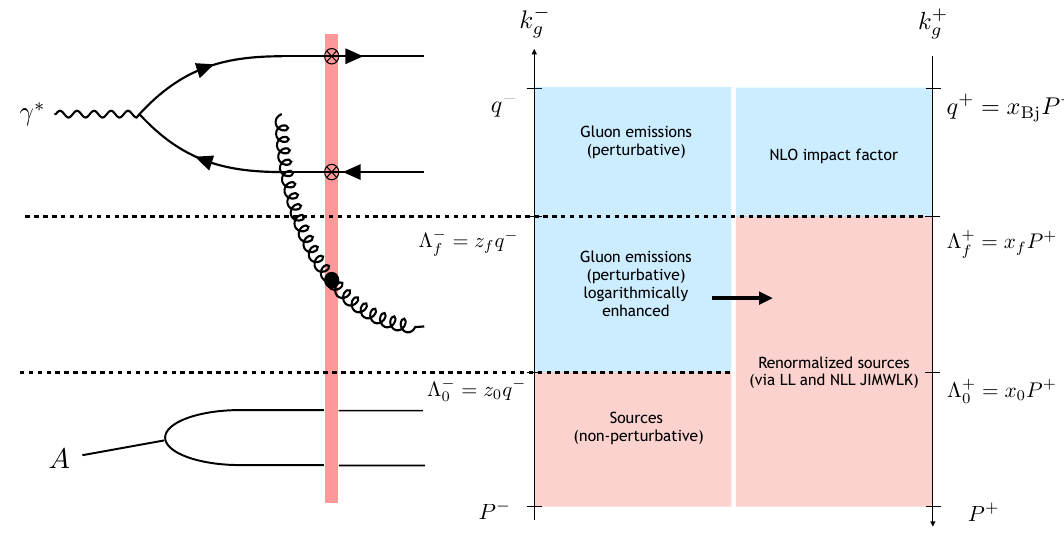
Figure 11 . Gluon emission (real or virtual) phase space. Fluctuations carrying “minus” (“plus”) lightcone momentum P − < k − < z 0 q − ( P + > k + > x 0 P + ) are accounted for in the sources. Emis- g g sions in the interval z 0 q − < k − < z f q − (or equivalently x 0 P + > k + > x f P + ) are logarithmically g g enhanced α s ln( z f /z 0 ) ≈ α s ln( x 0 /x f ) and are absorbed by renormalization of sources via JIMWLK evolution. The emissions in the interval z f q − < k − < q − (or equivalently x f P + > k + > x Bj P + ) g g are not logarithmically enhanced and are part of the NLO impact factor. The value of x f can vary depending on the kinematics of the final state. With each successive order in perturbation theory, one expects the corresponding uncertainties to diminish allowing for increasingly quantitative com- parisons with